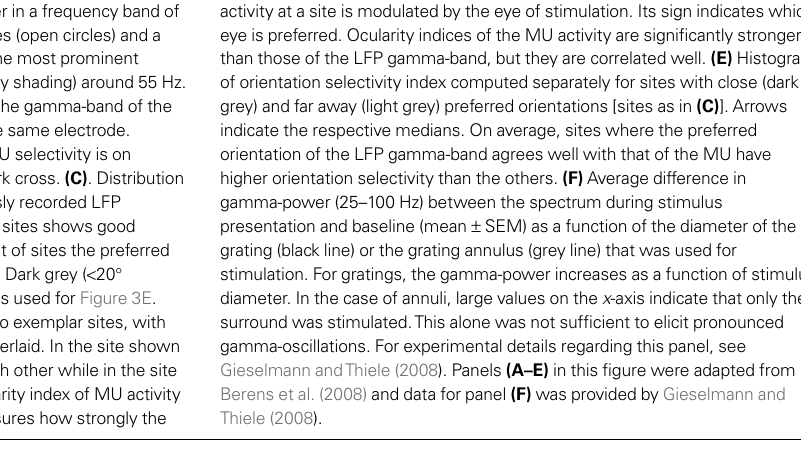
activity at a site is modulated by the eye of stimulation. Its sign indicates which eye is preferred. Ocularity indices of the MU activity are signifi cantly stronger than those of the LFP gamma-band, but they are correlated well. (E) Histogram of orientation selectivity index computed separately for sites with close (dark grey) and far away (light grey) preferred orientations [sites as in (C) ]. Arrows indicate the respective medians. On average, sites where the preferred orientation of the LFP gamma-band agrees well with that of the MU have higher orientation selectivity than the others. (F) Average difference in gamma-power (25–100 Hz) between the spectrum during stimulus presentation and baseline (mean ± SEM) as a function of the diameter of the grating (black line) or the grating annulus (grey line) that was used for stimulation. For gratings, the gamma-power increases as a function of stimulus diameter. In the case of annuli, large values on the x -axis indicate that only the surround was stimulated. This alone was not suffi cient to elicit pronounced gamma-oscillations. For experimental details regarding this panel, see Gieselmann and Thiele (2008). Panels (A–E) in this fi gure were adapted from Berens et al. (2008) and data for panel (F) was provided by Gieselmann and Thiele (2008).